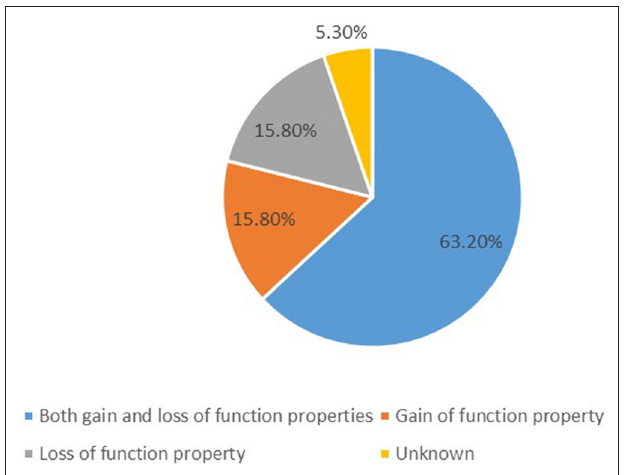
FIGURE 1 | A summary of functional properties of the 19 identified potassium channels gene